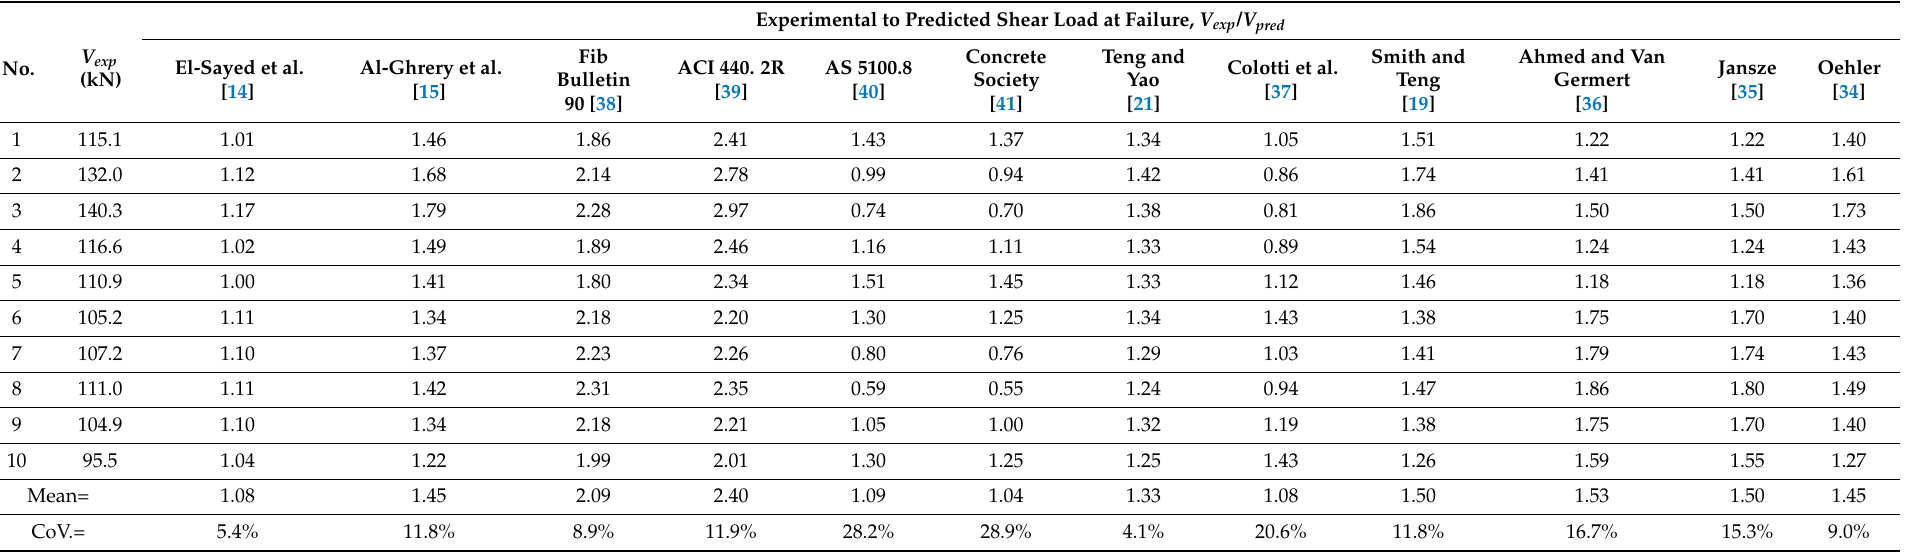
Table 6. Comparisons of shear-based models for prediction of plate end debonding capacity of the tested